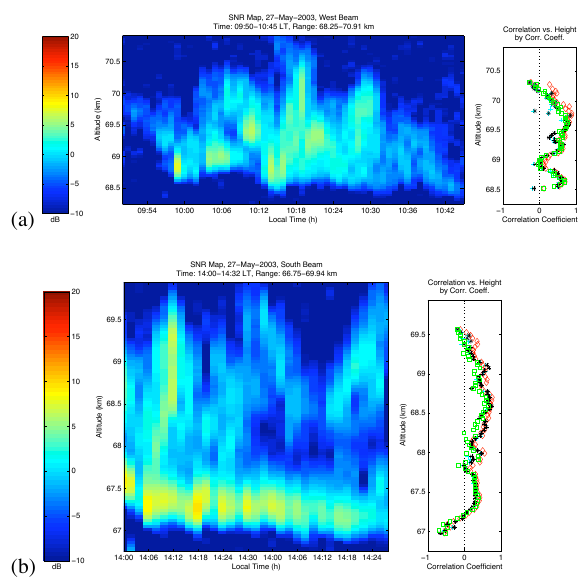
Fig. 8. A multi-blob layer centered at 71 km on May 28 at 13:10 LT. Fig. 6. Thin layer on 27 May (a) at 69km, 13:00 LT and (a) at